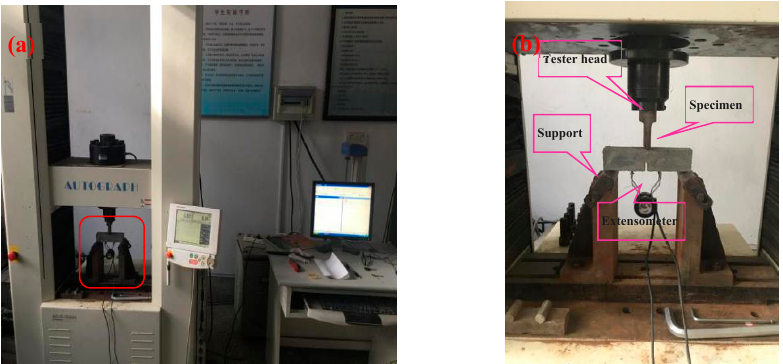
Figure 3. ( a ) The configuration of fracture toughness testing and the Shimadzu data acquisition system; ( b ) the function layout for the local-enlarged red round-angle box of ( a ).